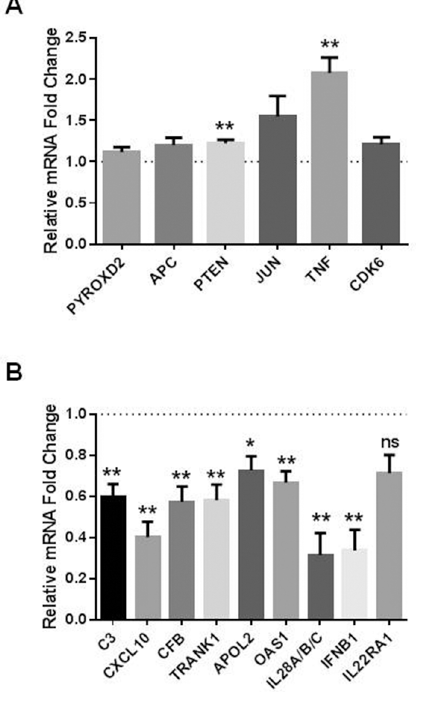
Figure 4. Identification and validation of miR-187-regulated target genes. Digital gene expression profiling was performed on OE33 R cells transfected with either pre-miR-187 vector or a scrambled vector control; miR-VC expression is normalized to 1 and is represented by the dashed line. (A) qPCR validation of genes upregulated following miR-187 overexpression. PTEN and TNF are significantly increased in cells overexpressing miR-187 when compared with a scrambled vector control (miR-VC). (B) qPCR validation of genes downreg- ulated following miR-187 overexpression. C3, CXCL10, CFB, TRANK1, APOL2, OAS1, IL28A/B/C and IFN b 1 were significantly downregulated in cells overexpressing miR-187 when compared with a scram- bled control. Data are presented as the mean ± SEM from five independent exper- iments. Statistical analysis was performed using the one sample t test; * p < 0.05, ** p < 0.01, ns not